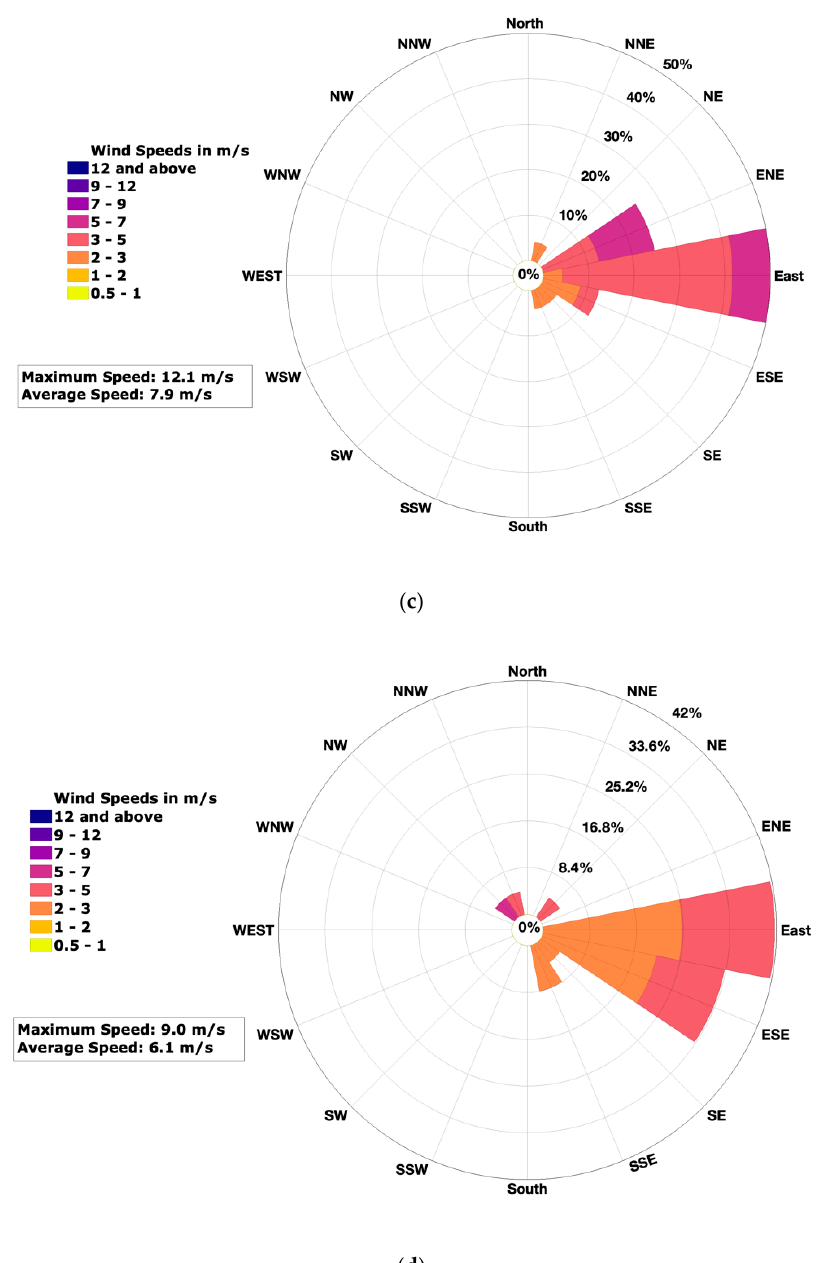
Figure 8. Wind roses for ( a ) 4 June, ( b ) 5 June, ( c ) 6 June, and ( d ) 7 June, providing details of the percentage (%) frequency of the wind speed from a direction as recorded at the TCEQ CAMS 12 (UTEP) during the successive high ozone episodes. Each color represents wind intensities as follows: navy blue: 12 and above m/s; violet: 9–12 m/s; purple: 7–9 m/s; magenta: 5–7 m/s; red: 3–5 m/s; orange: 2–3 m/s; amber: 1–2 m/s and yellow: 0.5–1 m/s.